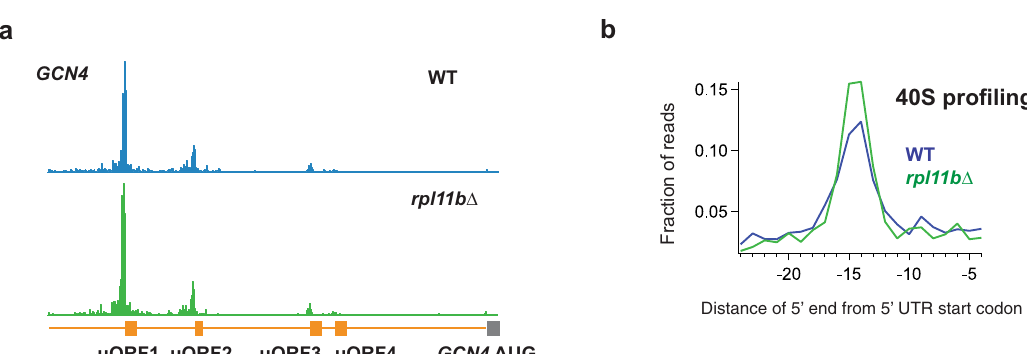
Fig. 3 40S reads are enriched on start codons at upstream ORFs (uORFs). a 40S ribosome footprint pro fi les of the 5 ′ UTR of the GCN4 gene showing 40S footprint occupancy peaks at 5 ′ UTR uORF AUG codons. Gene annotations are drawn to correspond to data for ribosome P sites. b Average fraction of 40S ribosome occupancy in a window surrounding 5 ′ UTR AUG codons. Data shown for WT and rpl11b Δ cells. Source data are provided as a Source Data fi le. See also Supplementary